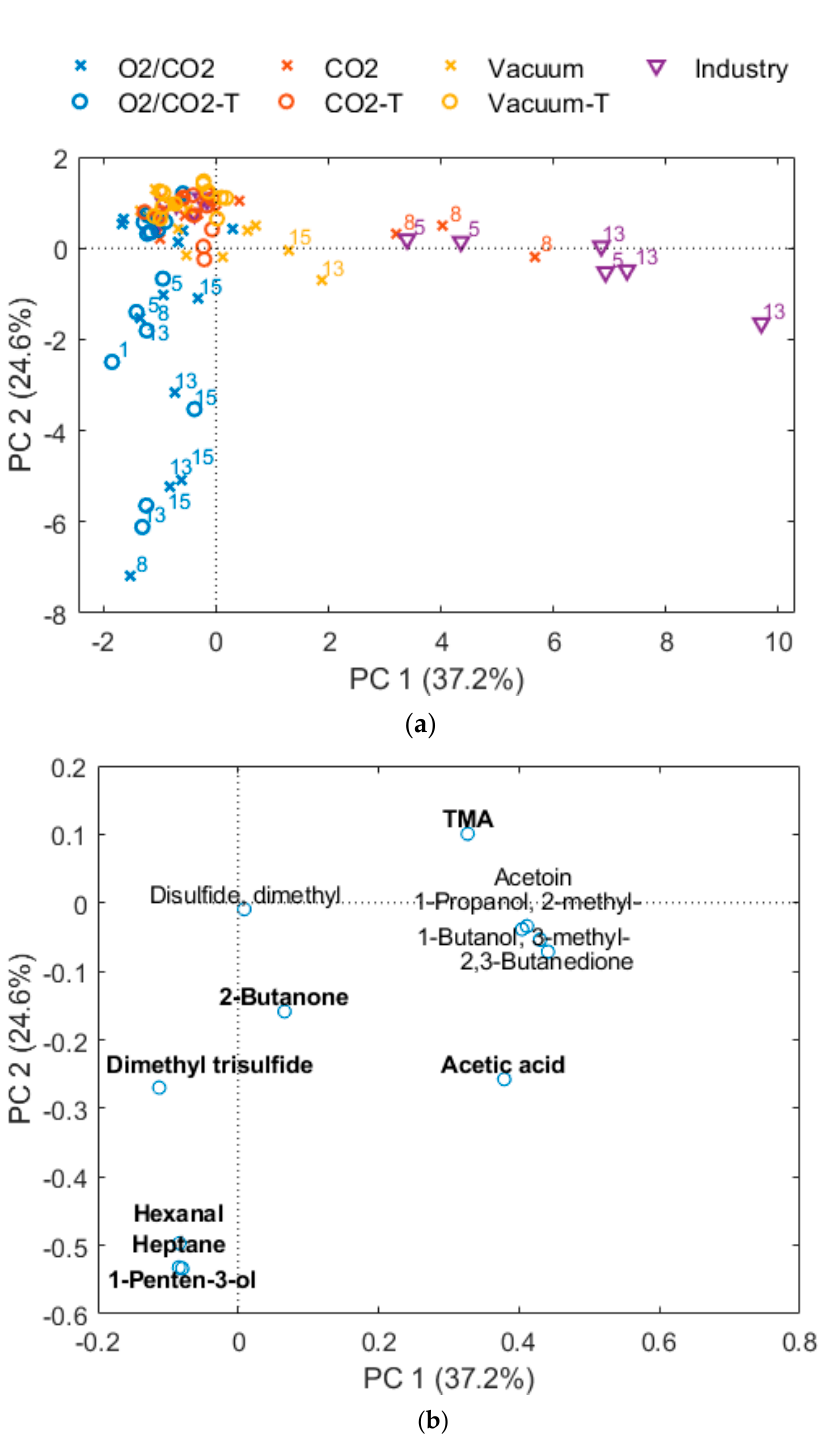
thawed (circle symbol) samples. The “CO 2 ” samples (red color) are packaged with 60% CO 2 , 40% N 2 and a CO 2 emitter, and “O 2 /CO 2 ” (blue color) is packaged with 60% CO 2 and 40% O 2 . “Industry” samples (purple triangle symbol) and “Vacuum” samples (yellow color) are packaged with vacuum. ( a ) Scores plot (13 days of storage are indicated by label), ( b ) loading plot: odor attributes.